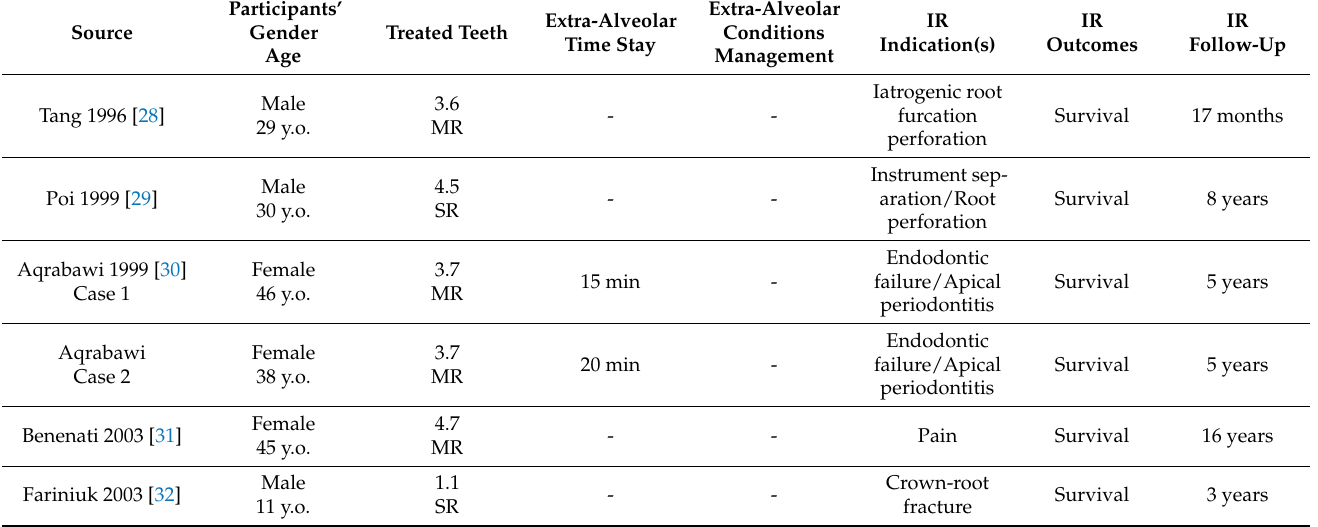
Table 1. Included studies characteristics: source, study participants’ gender and age; treated teeth, extra-alveolar time stay, and extra-alveolar environmental conditions management; IR indication(s), outcomes and follow-up. Abbreviations: y.o., years old; MR, multi-rooted; SR, single-rooted; IR, In- tentional Replantation.